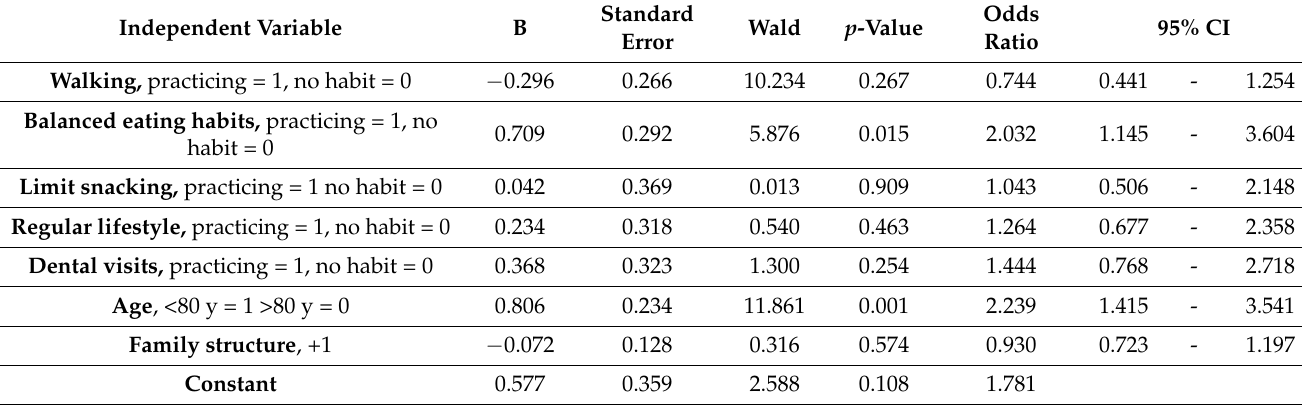
Table 8. Logistic regression analysis of anxiety and stress as dependent